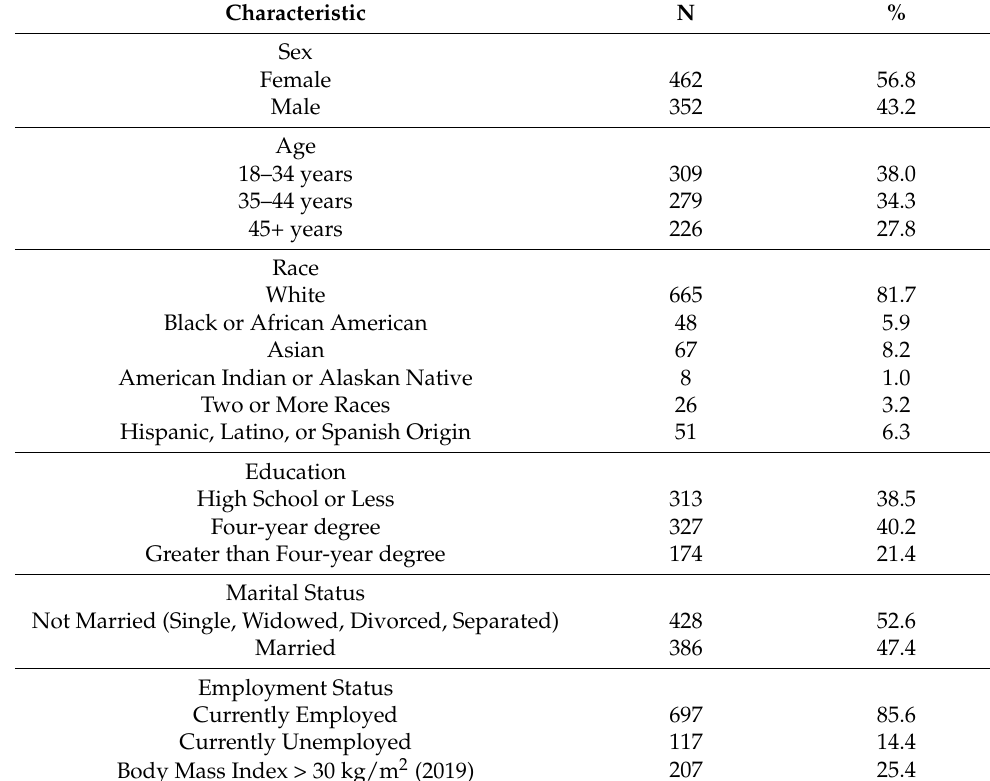
Table 1. Characteristics of included study